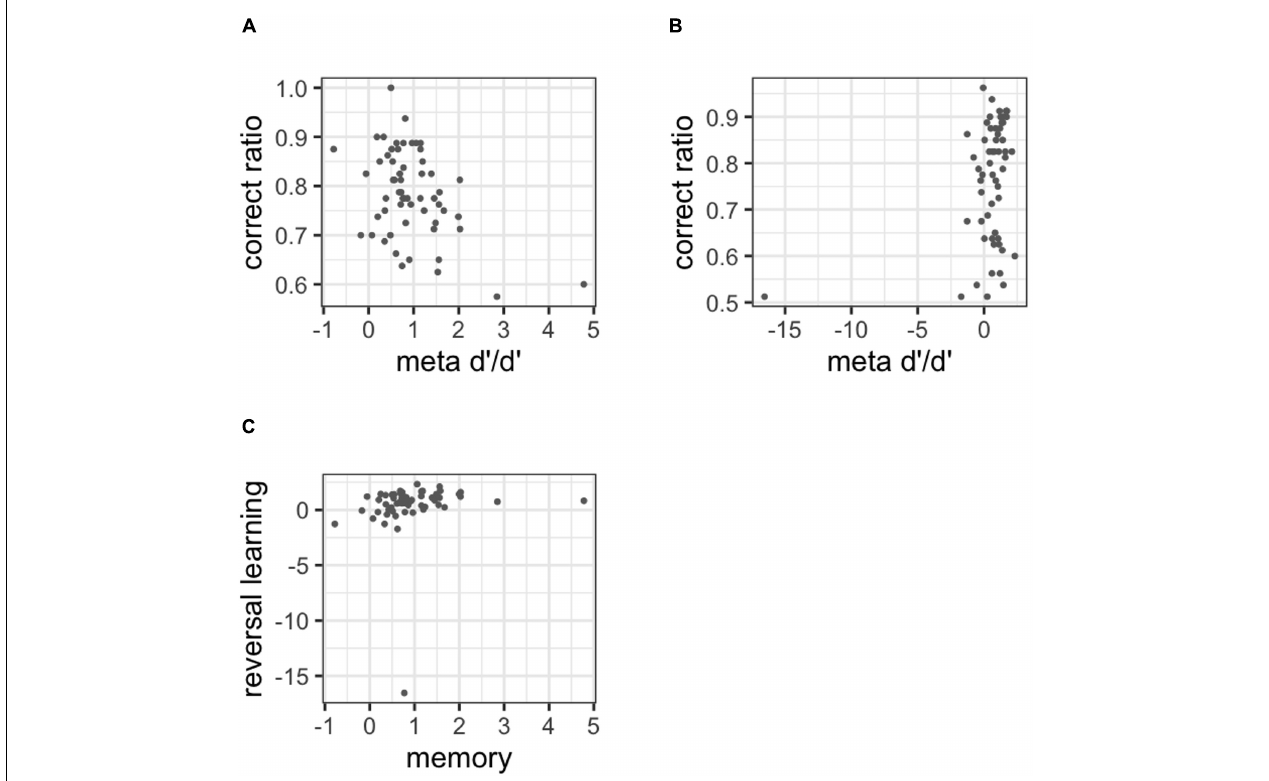
FIGURE 9 | (A) Correlations between the correct ratio and meta- d ’/ d ’ in the memory task, (B) correlation between the correct ratio and meta- d ’/ d ’ in the reversal learning task, (C) correlation with meta- d ’/ d ’ between